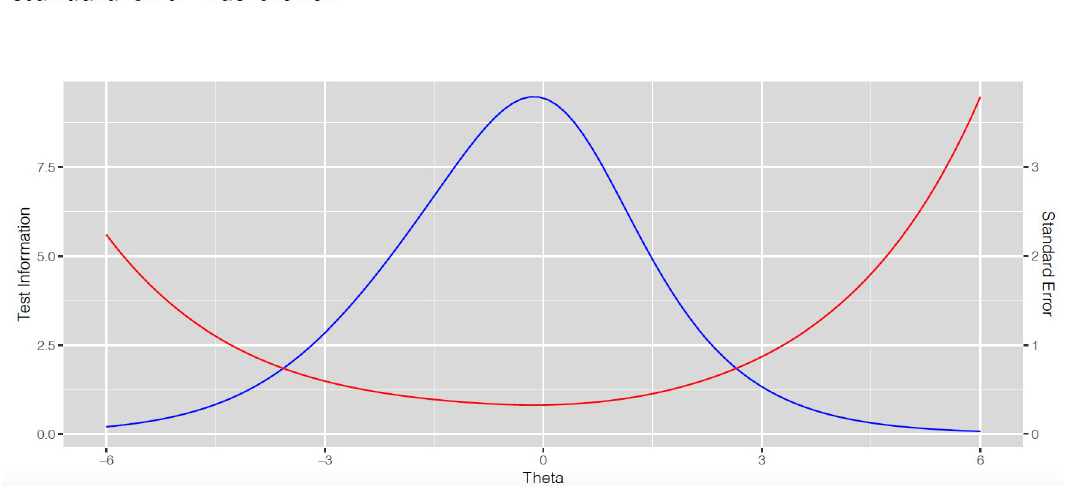
Fig 4. Embedded narration, test information, and standard